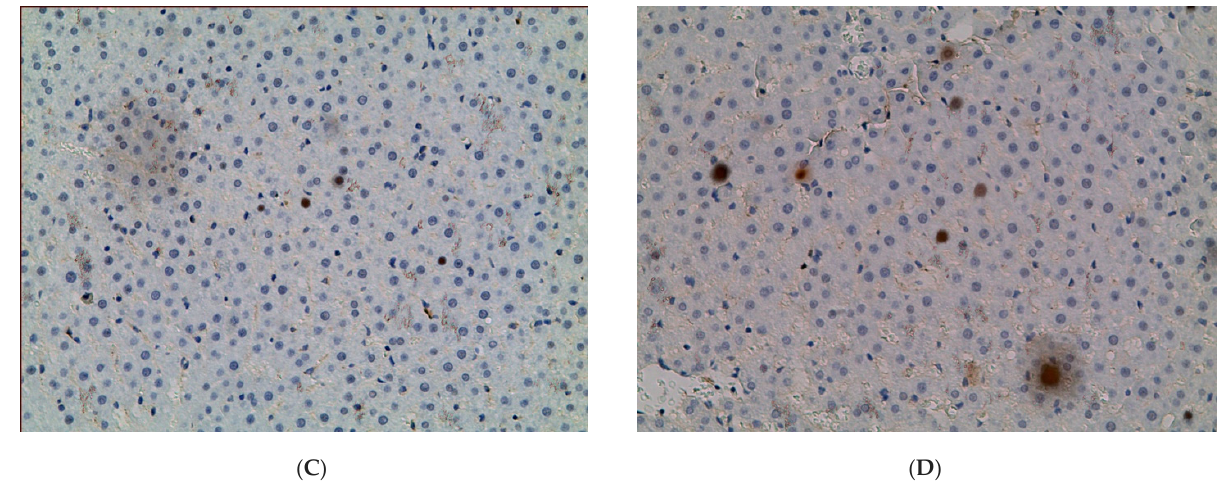
Figure 4. Expression of Ki-67 in liver of rats. ( A )—Control; ( B )—EtOH; ( C )—CL; ( D )—EtOH+CL. ×200. In hepatocytes of animals of control group, p53 expression was observed in 2.32 ± 0.50% of hepatocytes. It increased in animals of all experimental groups: 2.81 times higher in EtOH group (6.51 ± 0.94%), 2.06 times higher in CL (4.78 ± 0.63%), and 2.02 times higher (4.68 ± 0.95%) in EtOH + CL group (Figure 5 and Section 2.3).